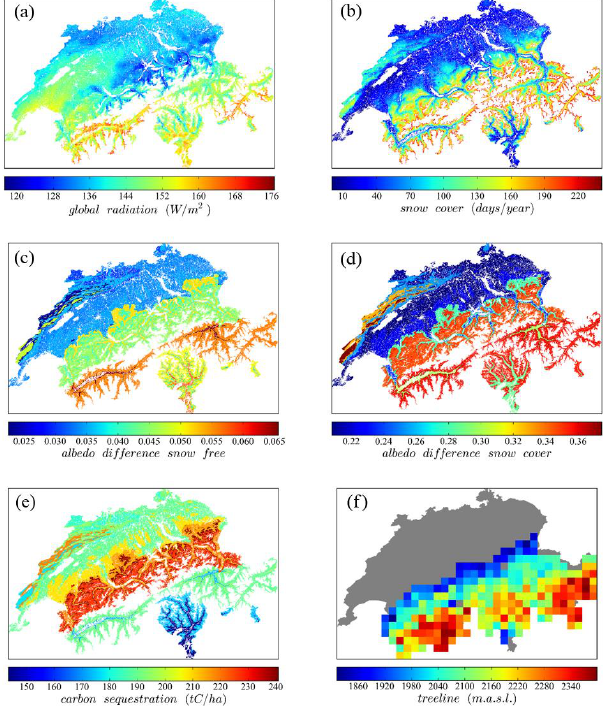
Figure 3. (a) Mean yearly global radiation. (b) Days with snow cover per year. (c) Albedo difference without snow (difference be- tween intensively and extensively used open land and closed for- est). (d) Albedo difference with snow (difference between inten- sively and extensively used open land and closed forest). (e) Carbon sequestration (difference between intensively and extensively used open land and closed forest). (f) Treeline elevation calculated using the Swiss area statistics of 1997 and applying the method of Paulsen and Körner (2001).